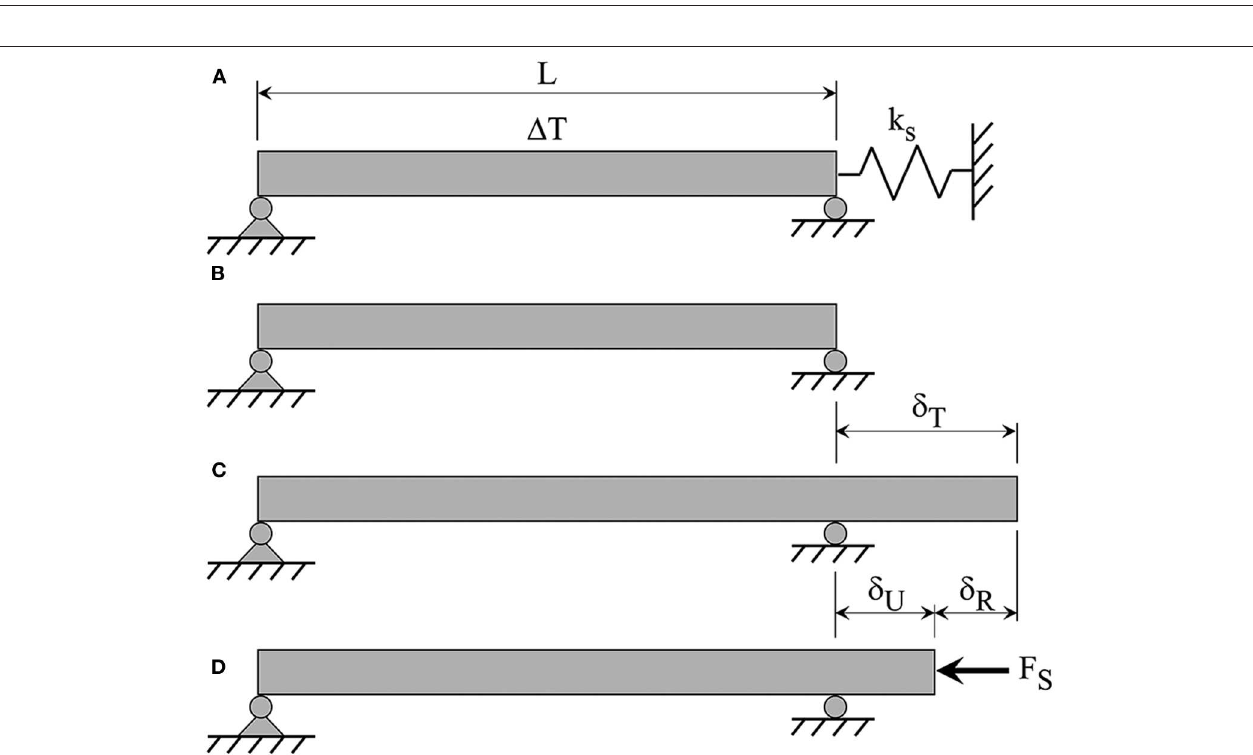
FIGURE 2 | (A) simple span beam with a longitudinal spring, (B) beam without spring support, (C) total deformation due to uniform temperature change, and (D) restrained deformation due to spring force (shown in the negative